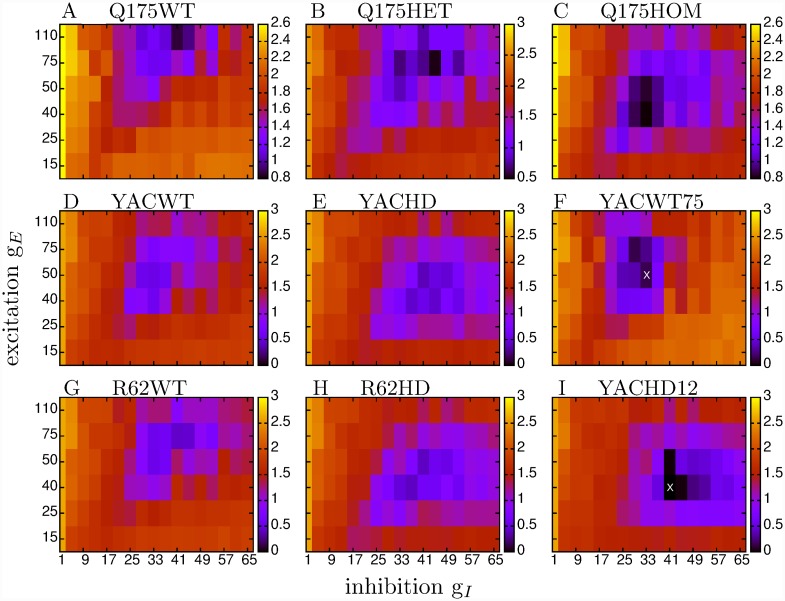
Heat maps showing goodness of fit measure, log(KL), (the lower the better), for multiple network simulations compared to different experimental datasets.(a) Q175WT, (b) Q175Het, (c) Q175Hom, (d) YACWT, (e) YACHD, (g) R62WT, (h) R62HD, (f) restricted age YACWT dataset denoted ‘WT75’, (i) restricted age YACHD dataset denoted ‘HD12’. In each panel the x-axis shows network model inhibition, gI, and the y-axis network model excitation, gE. Note gE is not equally spaced. Each small square, corresponding to a particular gI, gE pair, in each panel shows the KL distance, log(KL), for that network simulation from the particular experimental dataset. The bars on each panel show the log(KL) colourscale. (f,i) These two datasets are indicated by the pink arrows in Fig 11(a) and 11(b) and their spiking characteristics are shown in Figs 8, 9(a), 9(c) and 9(e). The crosses indicate the best fit model simulations whose spiking characteristics are shown in Figs 8, 9(b), 9(d) and 9(f).